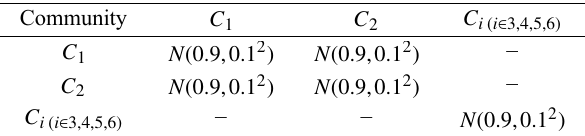
Table 3 Levels of intra- and inter-communities empathy. Community C 1 C 2